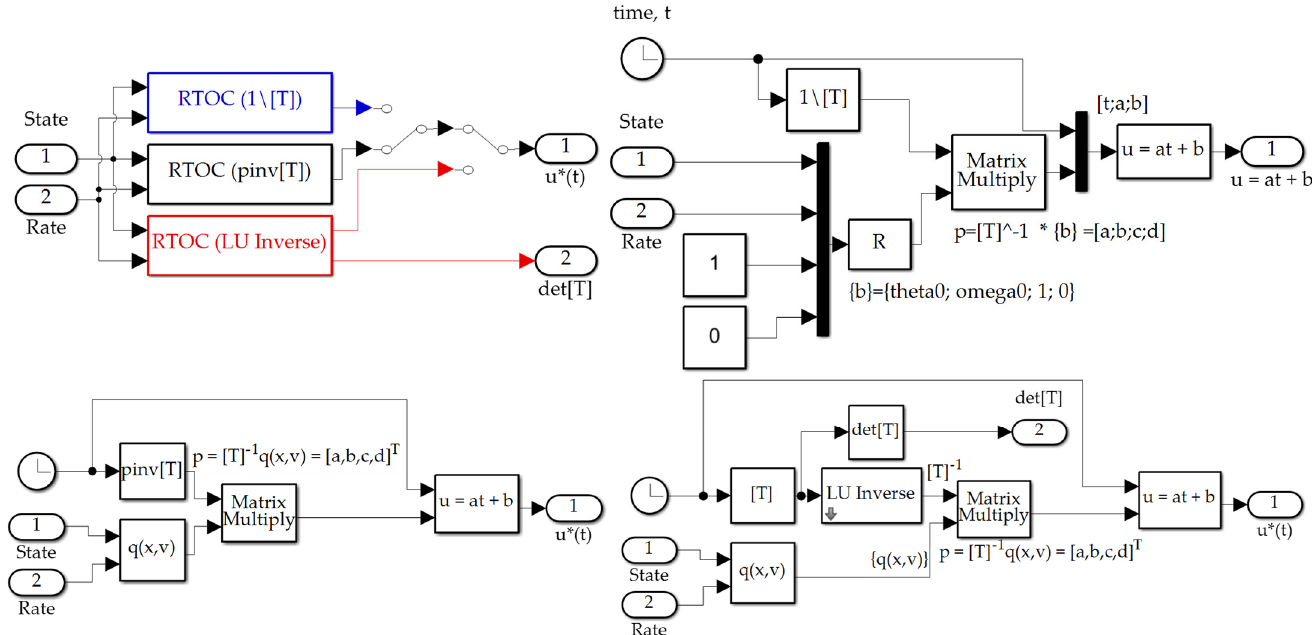
Figure 5. SIMULINK subsystems; ( a ) real-time optimal decision switching topology; ( b ) real-time optimal calculation of Equation (39) using backslash\inverse ; ( c ) real-time optimal calculation of Equation (39) using pinv inverse ; ( d ) real-time optimal calculation of Equation (39) using LU inverse .